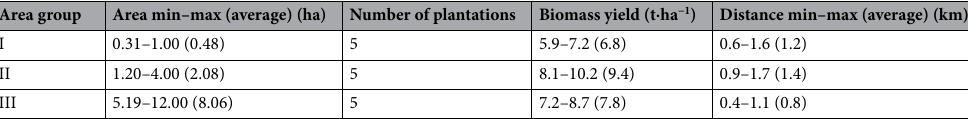
Table 2. General information regarding the plantations included in the study 57 .